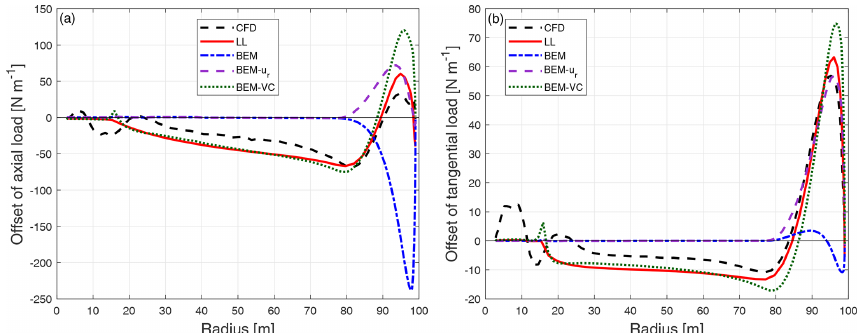
Figure B3. Comparison of the difference of the axial load (a) and tangential load (b) of the dihedral blade W-4 compared to the baseline blade calculated from different aerodynamic models.